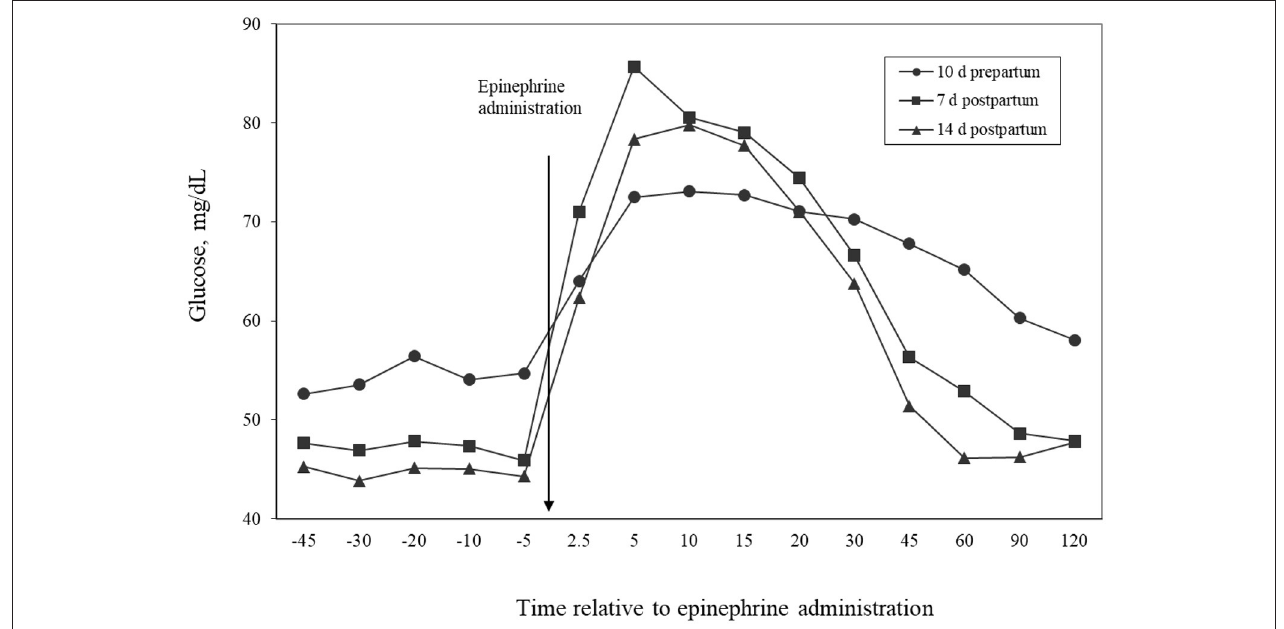
FIGURE 4 | Temporal patterns of concentrations of glucose in plasma relative to administration of epinephrine for cows administered epinephrine challenges at days 10, 7, or 14 relative to calving. Effects of day ( P = 0.07) and time relative to epinephrine administration ( P < 0.001).